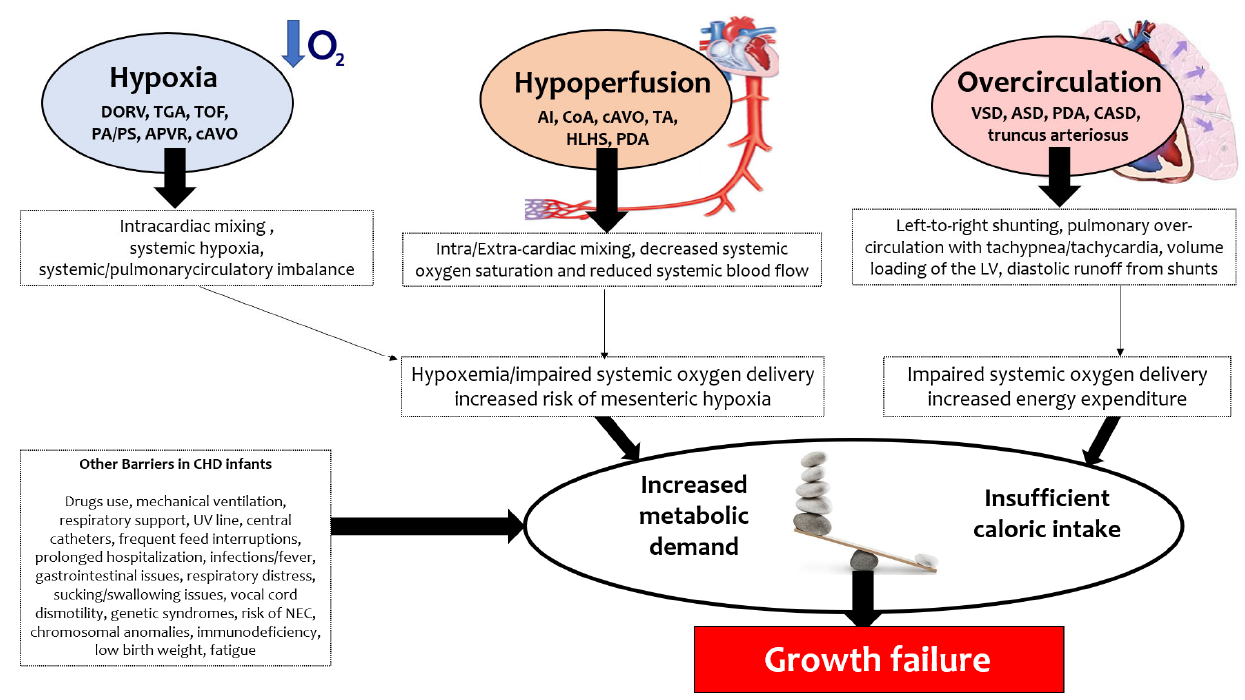
Figure 1. Growth failure mechanisms in congenital heart disease.